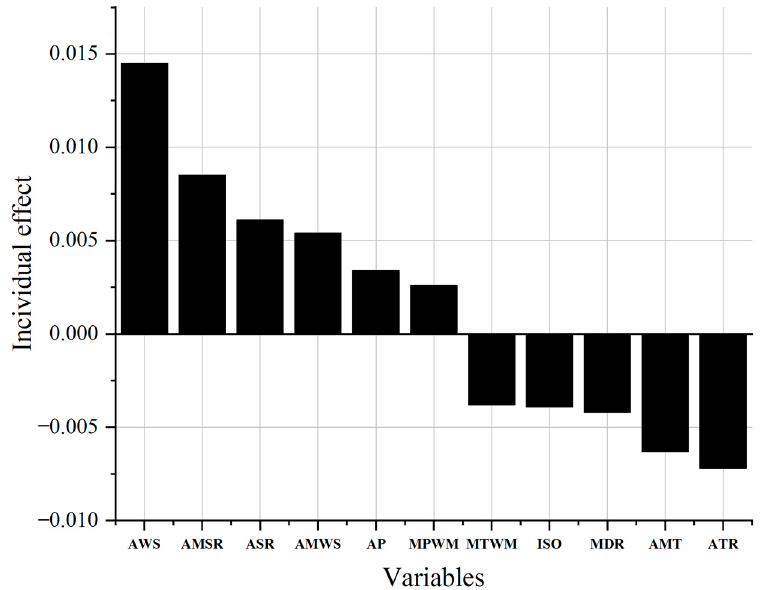
Figure 6. The relative importance of individual climate variables in predicting eaves length by rdacca.hp[38]. *If the incividual effect is a negative number which means the independent variable have little effect on the strain variable.